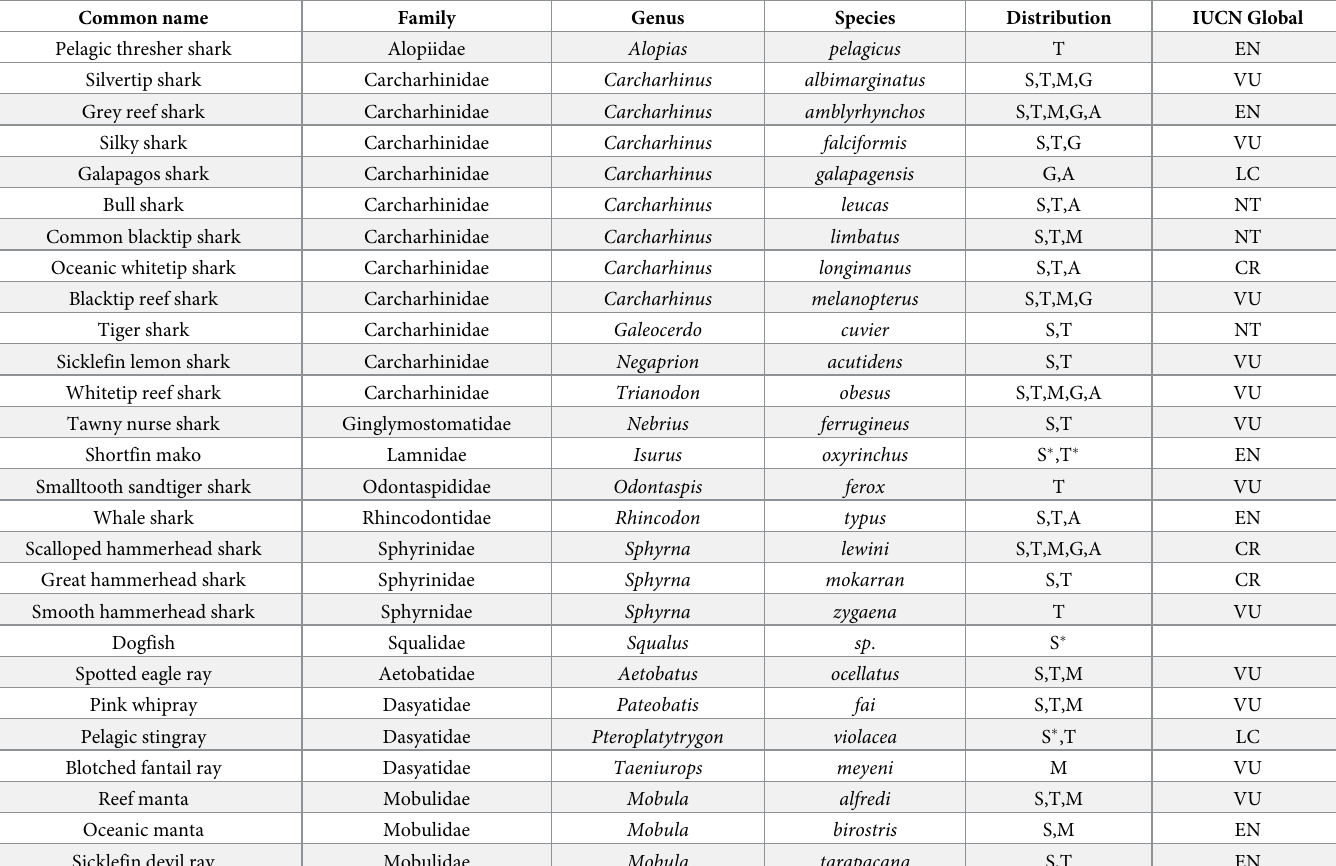
Table 1. Species of sharks and rays reported by the ORP observations in French